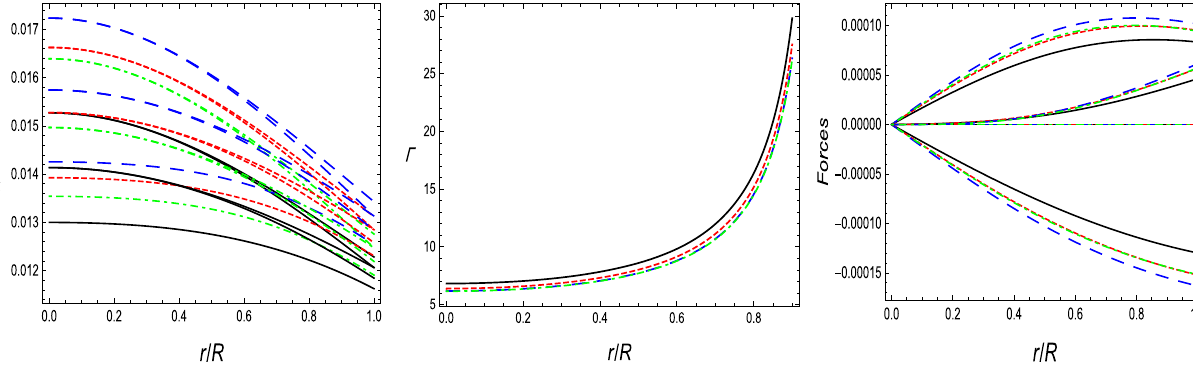
Fig. 4 Profiles of energy conditions { ρ + p r , ρ + p t ρ − p r − 2 p t , ρ − p r , ρ − p t }, adiabatic index ( (cid:12) ) and TOV forces versus radial coordinate, r . The same set of numerical values has been used to plot these graphs as mentioned in